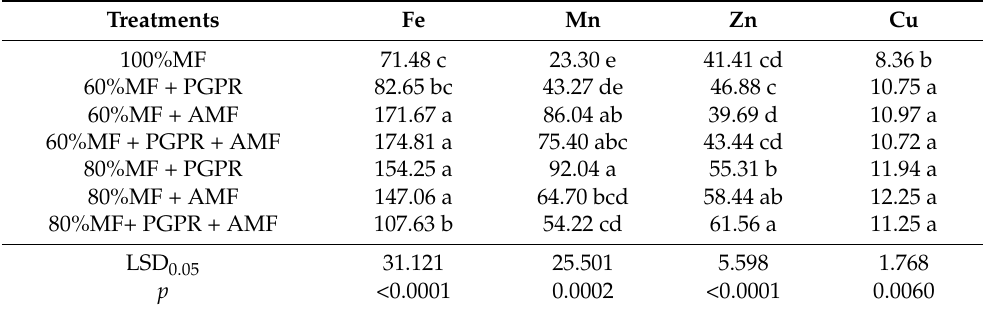
Table 7. Effects of the bio-fertilizers on leaf micronutrient concentrations (mg kg − 1 ). Treatments Fe Mn